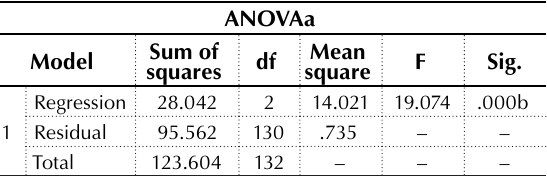
Table 10. Regression analysis between